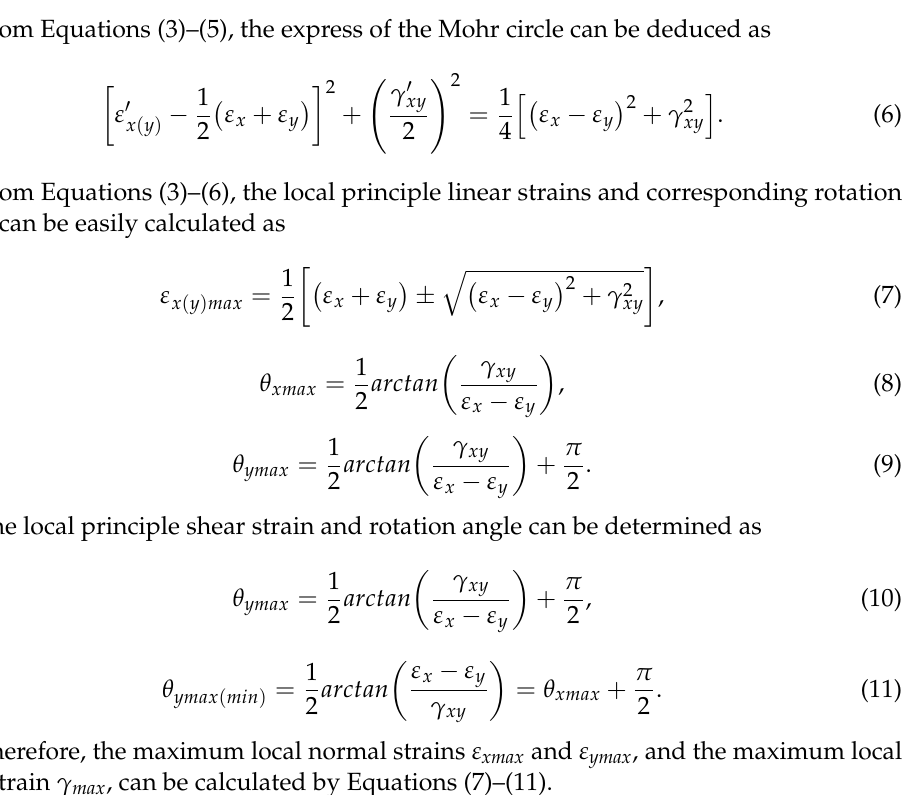
Figure 4. DIC images of strained 0° specimen: ( a ) speckle image of the 0° specimen before loading; ( b ) contour maps of the ε xmax field; ( c ) contour maps of the ε ymax field; ( d ) contour maps of the γ max field.